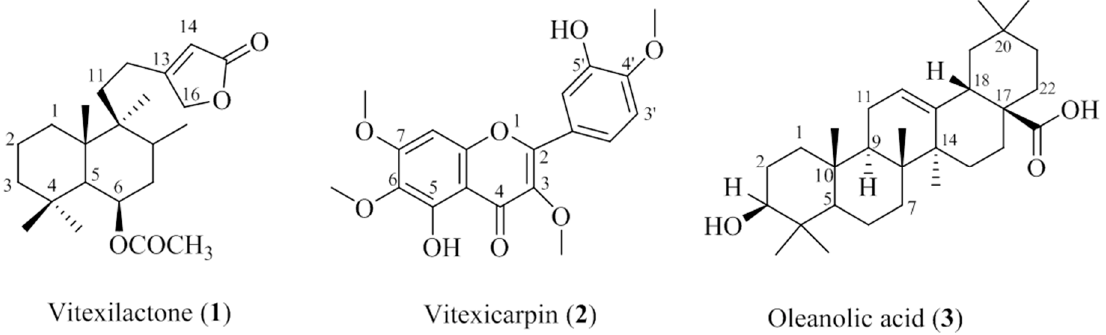
Figure 3. Compounds isolated from V. trifolia.